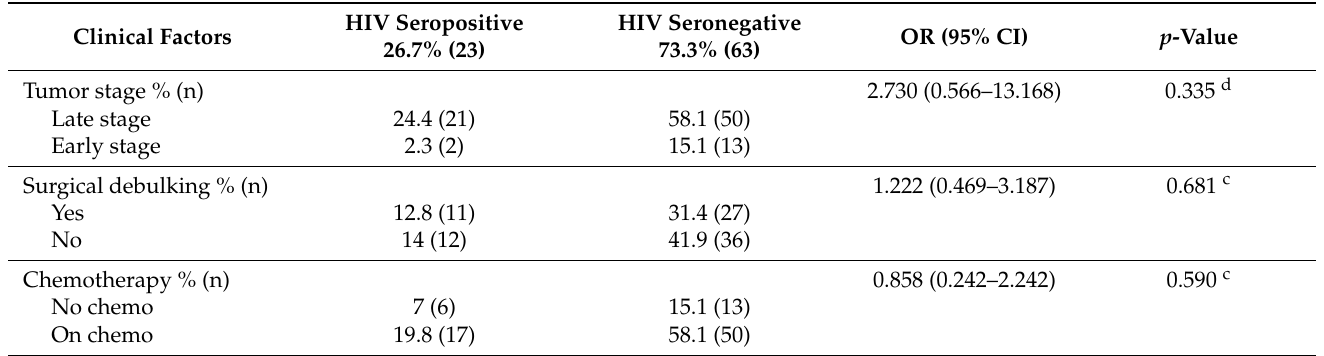
Table 5. Association of ovarian cancer patients’ HIV serological status with clinical factors.